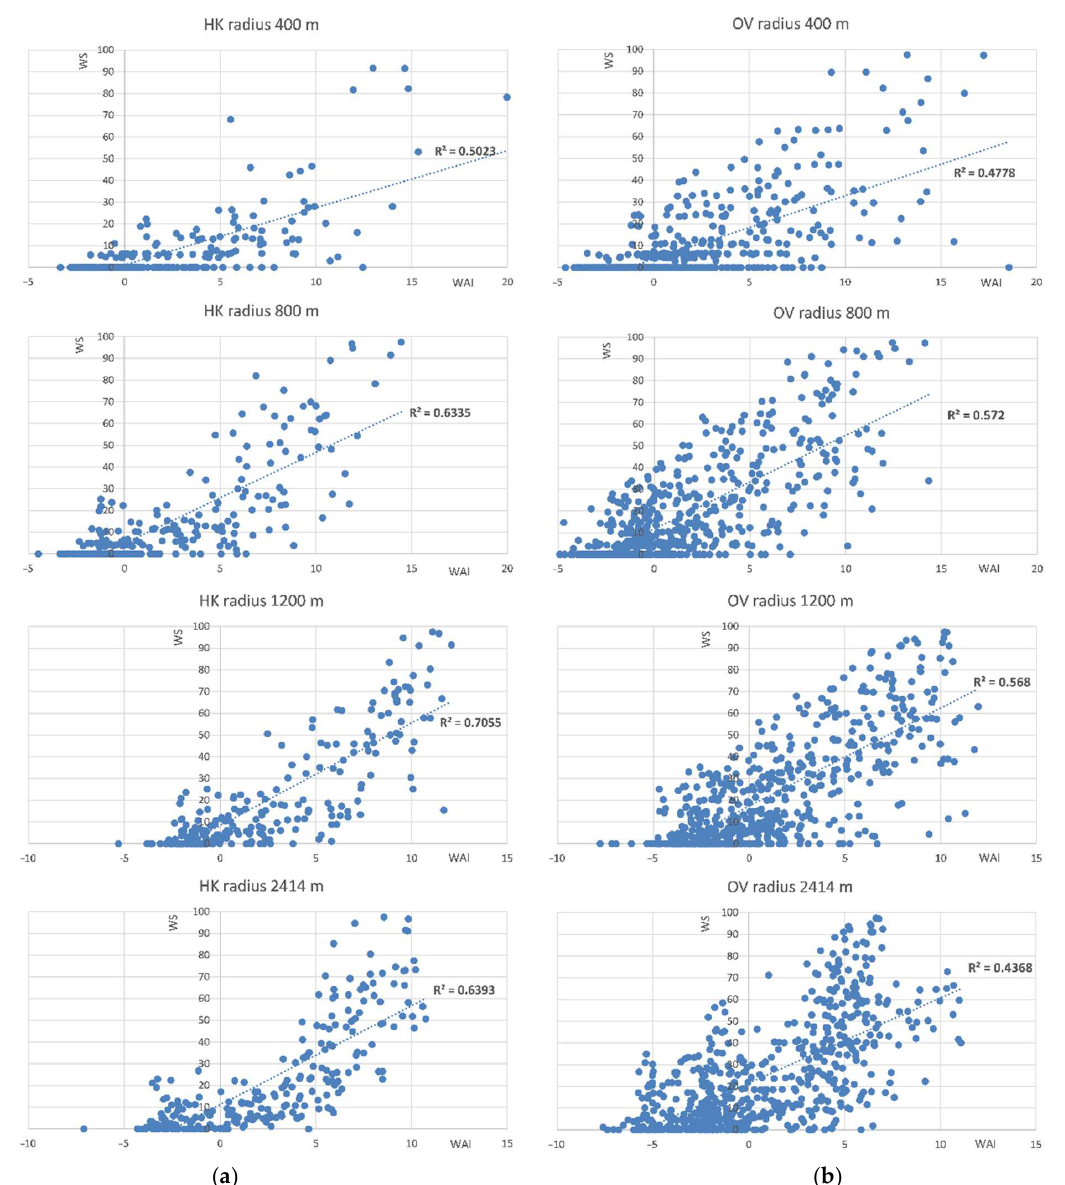
Figure 11. Correlation between WAI and standard WS (Hradec Kralove ( a ) and Ostrava ( b )). However, the distribution shows a diverse evaluation of WAI and WS. A close rela- tionship between these indicators is reached only with higher values of WAI, especially in the case of Hradec Kralove. Ostrava is more heterogeneous which is reflected in lower R 2 and higher diversity of situations. Extremely heterogeneous conditions can be seen for the largest radius where five partly separated clusters can be distinguished (Figure